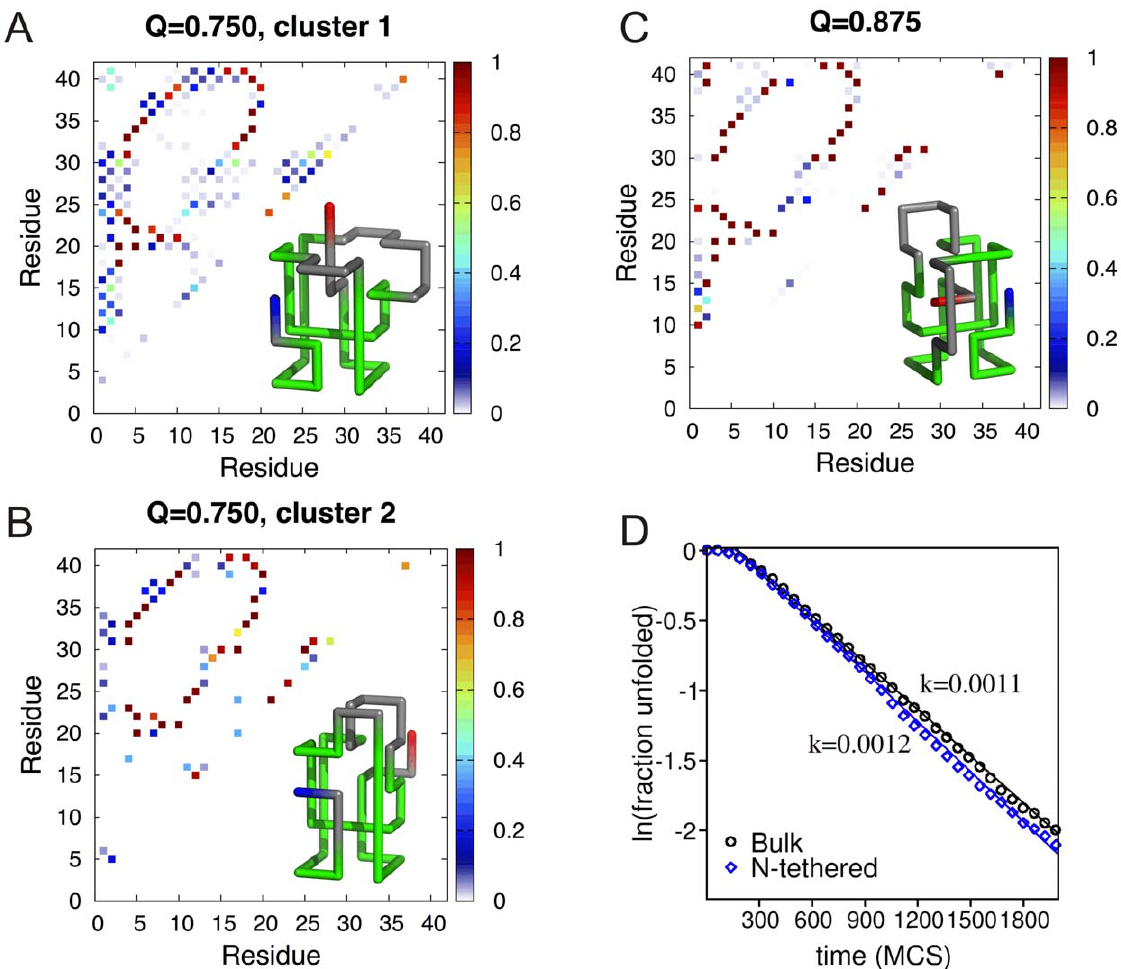
Figure 7. Probability maps showing the probability of occurrence of each established contact (native and non-native) in the two clusters of conformations with fraction of native contacts Q =0.75, which are populated by the knotted protein when it is surface- tethered at the C-terminus. Cluster 1 (A) is the dominant cluster and contains 58% of conformations in the original ensemble while cluster 2 (B) is the sub-dominant cluster containing the remaining 42%. Also shown (inset) is the representative conformation of each cluster. For Q =0.875 we could identify only one ensemble of conformations which is structurally well resolved and represents a folding bottleneck developing from the dominant cluster (C). The green color in the representative conformations highlights the portion of the backbone that is conserved across the three structures. Upon release from the plane and upon surface-tethering at the N-terminus the conformation with Q =0.875 folds rapidly to the native state (D). (Figure 9B). If this structural restraint is not imposed from early on